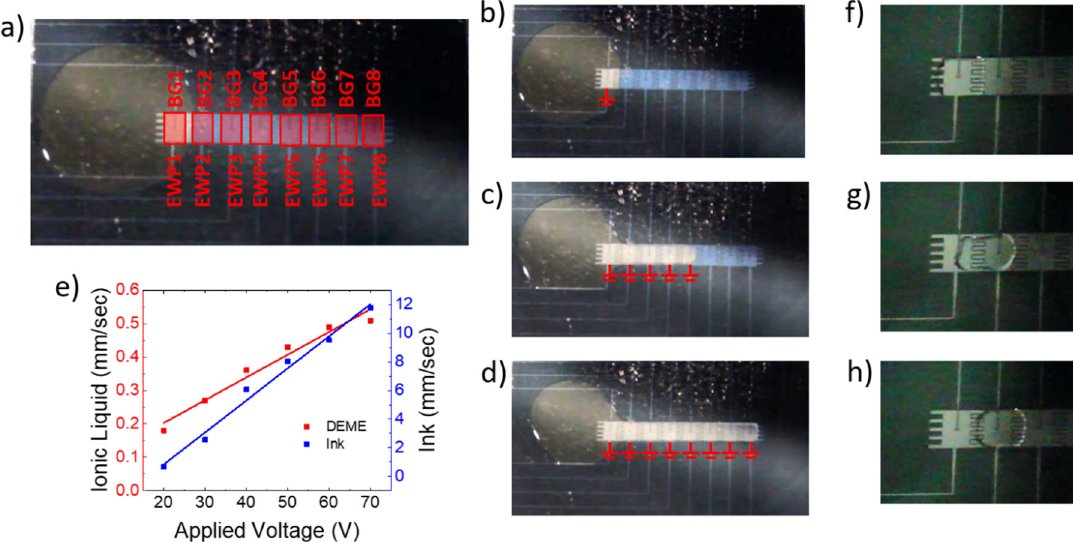
Figure 4. ( a ) Photograph of programmable electrofluidic neuromorphic device with the circular ionic liquid reservoir shown to the left (slight yellow tint) of the 1D electrowetting array. Overlaid in ( a ) are the rectangular pixels and the labels for the back gate contact lines (BG 1–8) and electrowetting pixel contact lines (EWP 1–8). ( b ) Channel formation with only EWP1 turned on. ( c ) Channel formation after EWP1–5 have been powered (10 s) and ( d ) channel formation of IL after all EWP1– EWP8 are powered (24 s). Electrowetting voltage in ( b – d ) and ( f – h ) was 20 V. ( e ) Plot of electrowetting speeds of DEME compared to a standard aqueous based yellow ink as a function of applied